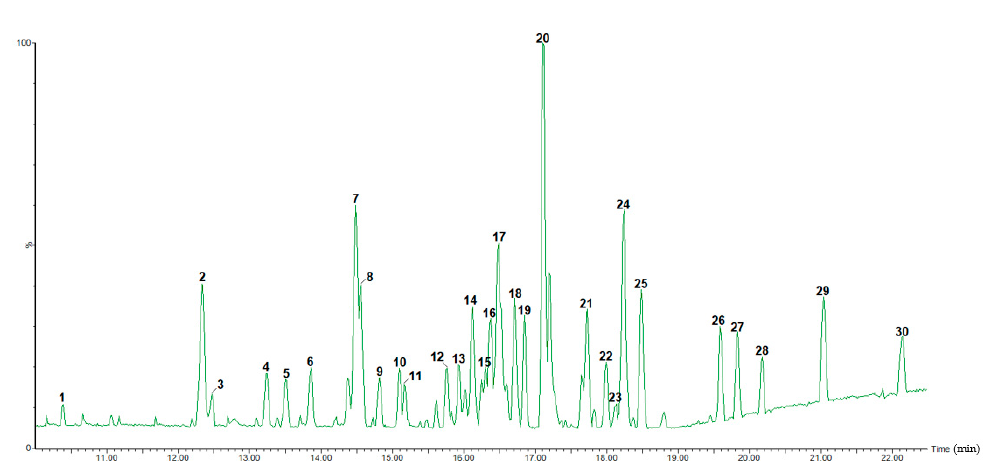
Figure 2. UHPLC-ESI-QTOF-MS base peak intensity (BPI) chromatogram (in negative ion mode) of the MeOH90-F fraction. Table 2. Chemical composition of the methanol 90% fraction of the total extract of C. cowellii . Peak